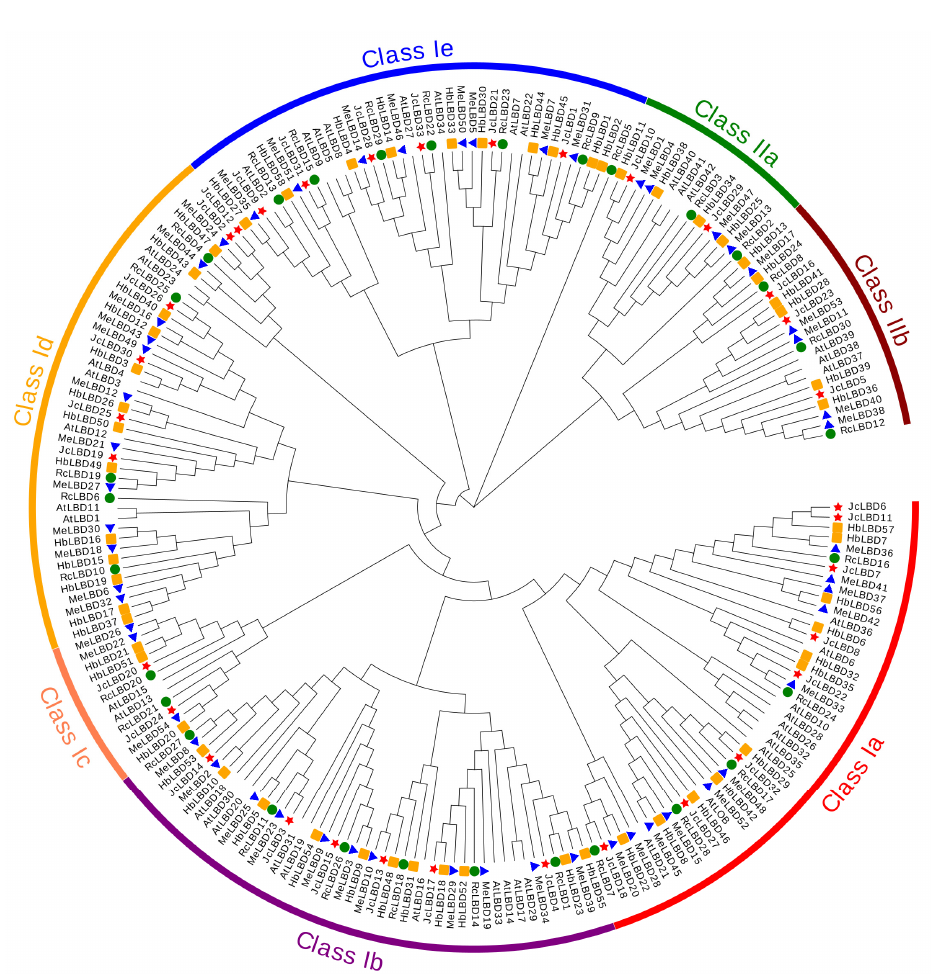
Figure 1. The phylogenetic tree of LBD genes of J. curcas , rubber tree, cassava, castor and A. thaliana was constructed by MEGA 10 using the maximum likelihood (ML) model. Red stars, orange rectangles, blue triangles, and green circles indicate J. curcas , rubber tree, cassava, and castor sequences, respectively.